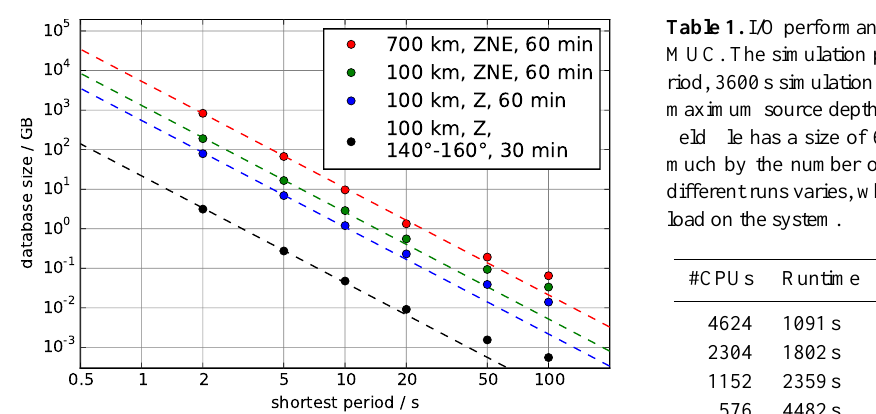
Figure 14. Storage requirements of the reciprocal databases for PREM after zip compression for all three components and several parameter sets (maximum source depth, components, seismogram length and epicentral distance range). Dashed lines are fitted func- tions g(f ) = af 2 . 7 , where each point was weighted with the fre- quency f to ensure better fitting at the higher frequencies. The ex- ponent is slightly smaller than the expected 3 because the zip com- pression is more efficient for longer time traces. At long periods, element sizes are governed by the layer thickness rather than the wavelength, resulting in the discrepancy from the power law at long periods.